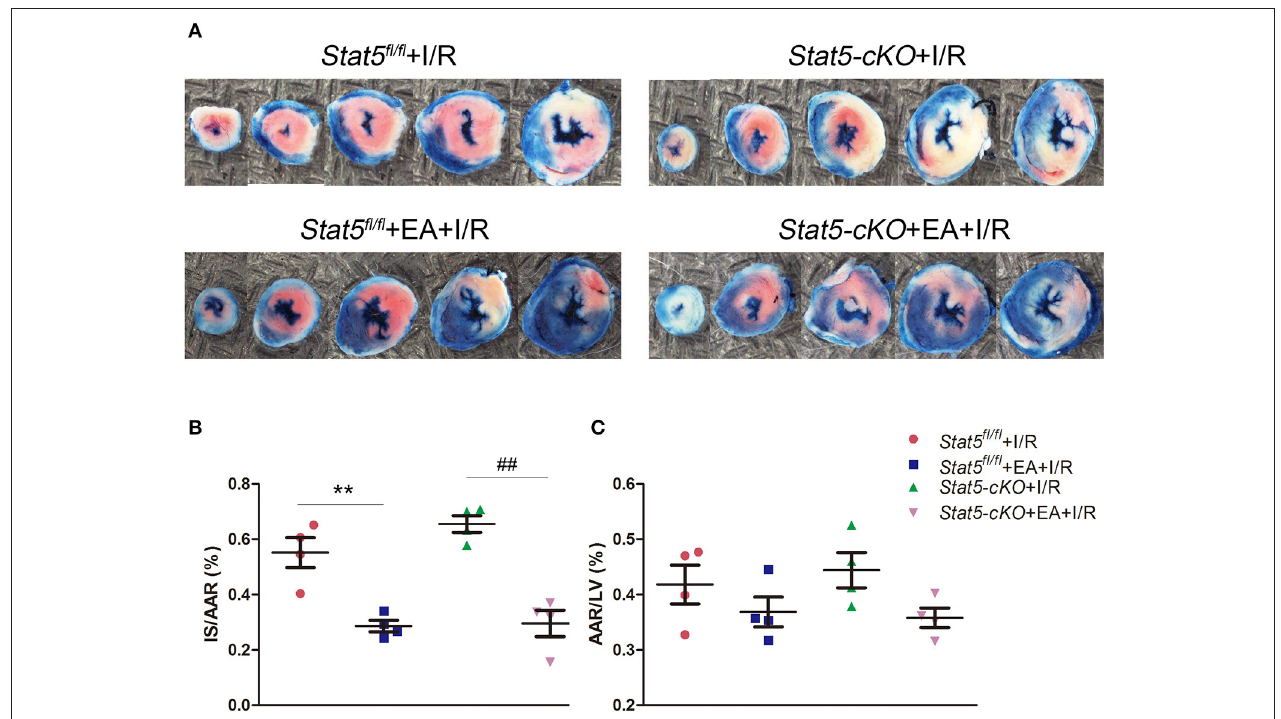
FIGURE 1 | Acupuncture reduced myocardial infarct size. (A) Evans blue/TTC double staining was used to measure the ischemic infarct area and area at risk (AAR). (B) The infarct size (IS)/AAR ratio was calculated and presented as a percentage. Data are presented as means ± SEM. Normal tissues are stained blue, ischemic infarct areas and AARs are pale white or red. ** P < 0.01 compared with Stat5 fl / fl + I/R group; ## P < 0.01 compared with Stat5- cKO + I/R group. (C) The ratio of AAR/total left ventricular (LV) area was calculated and presented as a percentage. There was no difference between the groups. Data were analyzed by one-way ANOVA with Tukey’s post-hoc correction, n =